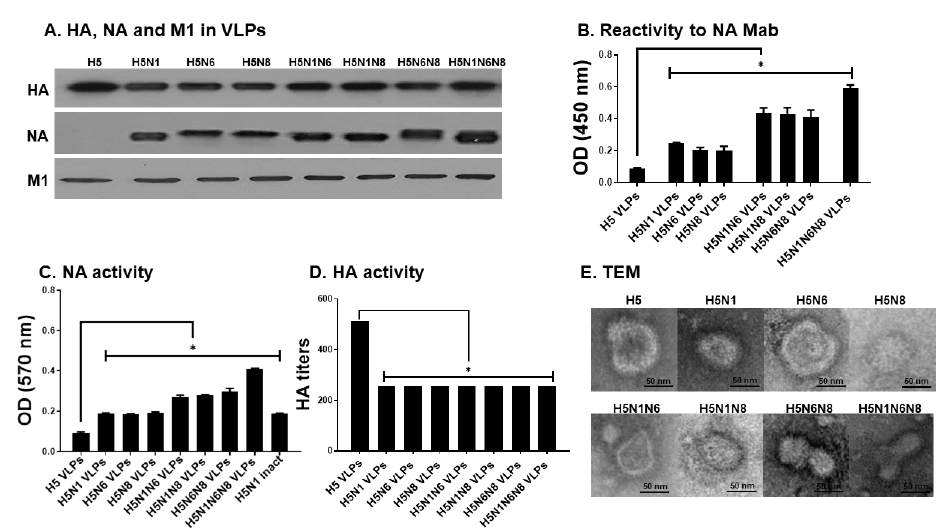
Figure 1. Characterization of influenza VLP vaccines. ( A ) The expression of NA, HA, and M1 pro- teins on VLPs was determined by western blot probed with rabbit HCA-2 monoclonal antibody, anti-H5N1 polyclonal antibody, and M1 monoclonal antibody. A total of 5 μ g of each influenza H5, H5N1, H5N6, H5N8, H5N1N6, H5N1N8, H5N6N8, and H5N1N6N8 VLPs were loaded in each lane. ( B ) The reactivity of VLPs to NA mAb (HCA-2) was measured by ELISA. ( C ) The activity of NA proteins in VLPs was determined by the Amplex Red neuraminidase assay kit. ( D ) The activity of HA protein in VLPs was determined by hemagglutinin activity assay using cRBC. ( E ) Influenza H5, H5N1, H5N6, H5N8, H5N1N6, H5N1N8, H5N6N8, and H5N1N6N8 VLPs were observed under a transmission electron microscope. All data are expressed as mean ± SD (* p < 0.05).